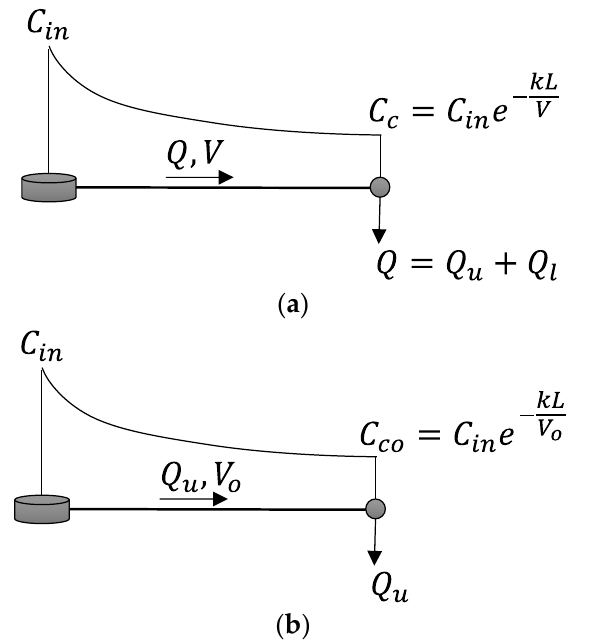
Figure 2. Disinfection concentration distribution for a single pipe network with one demand node at the pipe end, where ( a ) is with water loss and ( b ) is without water loss.